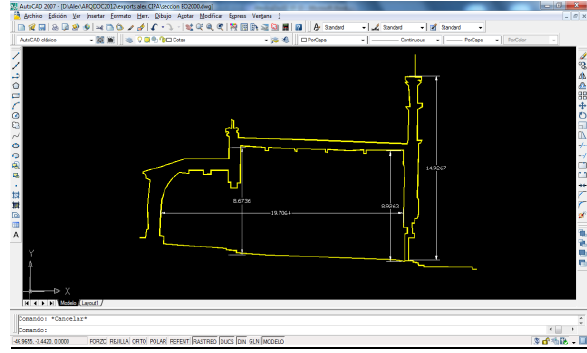
Figure 7. Cross section side view E – W